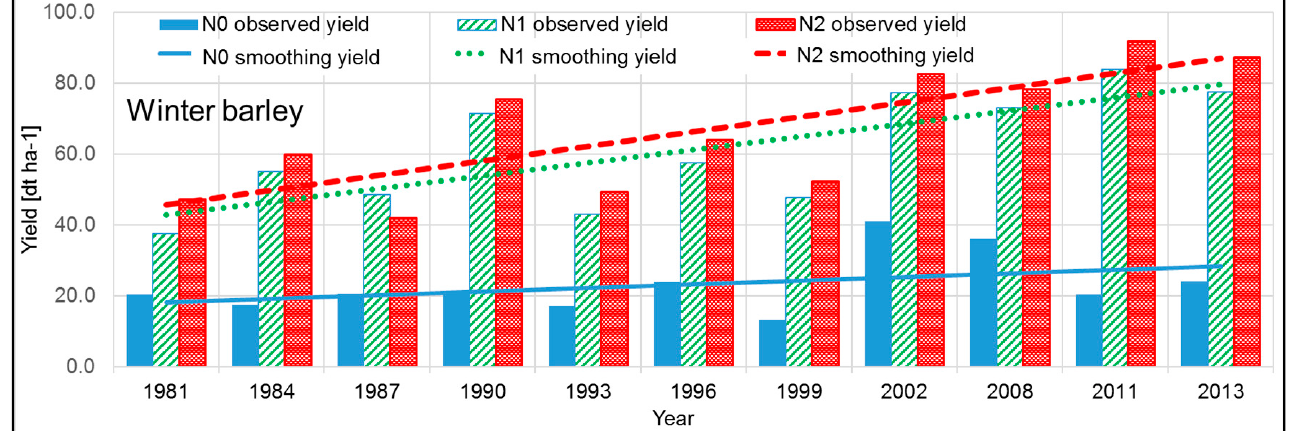
Figure 2. Annual yields of winter barley between 1981 and 2013, with smoothing lines for control and fertilized (unfertilized plots (N0), moderately fertilized plots (N1), and highly fertilized plots (N2)).